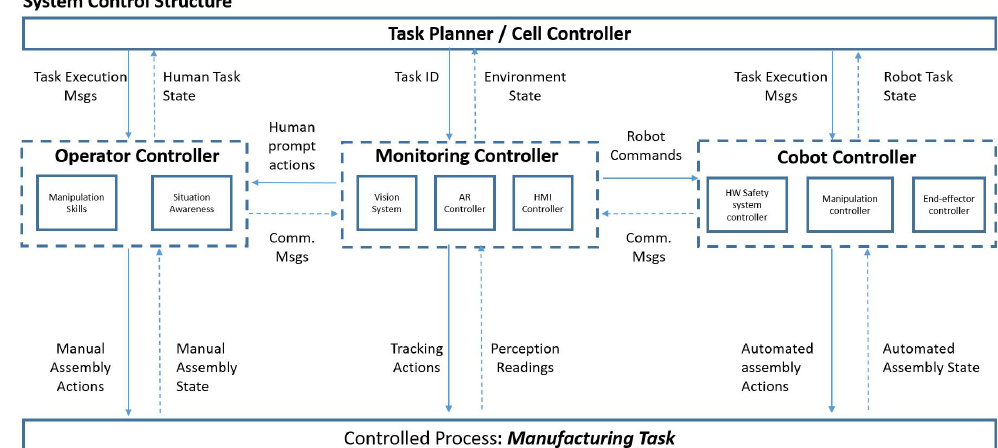
Figure 4. Control structure for the collaborative